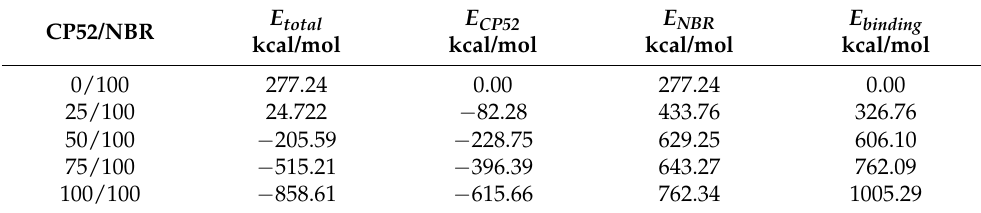
Table 4. E binding of the CP52/NBR system.